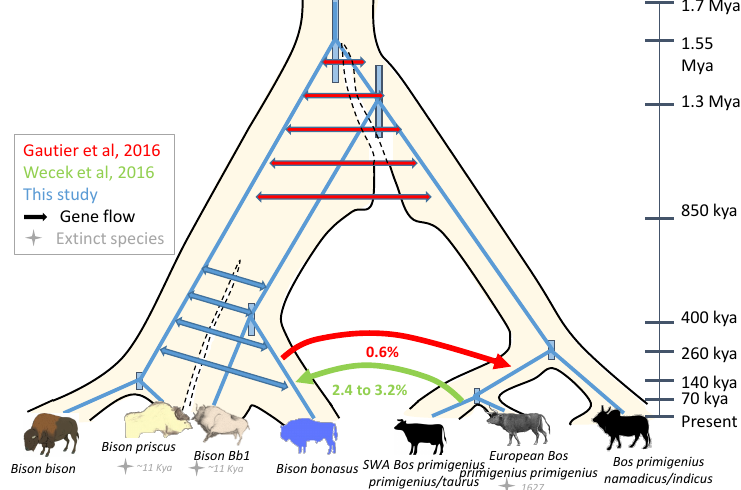
Figure 8. Schematic representation of the evolutionary tree of Bovina genomes. The tree recapitulates the various evolutionary events deduced from the mitogenome and nuclear genomes analyses discussed herein. We have represented the mitogenome lineages as blue lines using the date estimates and their highest posterior densities estimated from the Bayesian analyses represented in Figure 1. We have depicted as beige envelopes around these lines the corresponding populations as deduced from the genome analyses discussed in the text. Uncertainties about the extent of separation of populations and/or species still undergoing bidirectional gene flow are indicated with dotted lines. The estimated and proposed extended periods of divergence with limited gene flow are represented by series of double-sided arrows, whereas the various directional gene flows identified are represented by single-sided arrows alongside the fraction of the genomes that results from this gene flow event(s). The color code indicates the study of origin of the data gathered as indicated in the box. The dates estimated for the various evolutionary events are indicated as a linear time scale on the right-hand side. The extinct lineages/species are indicated by a star alongside their estimated period of